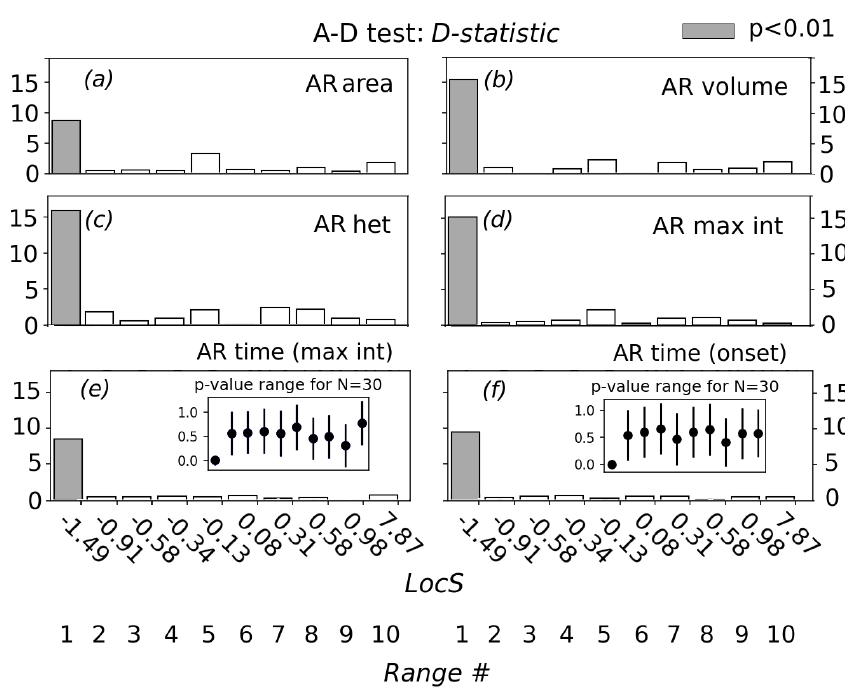
Figure 2. Sensitivity of afternoon rain properties to preceding soil moisture heterogeneity conditions. D-statistic of the Anderson–Darling (A–D) test, i.e., weighted average squared difference between the two selected Empirical Distribution Functions (EDF), for every LocS range ( x -axis) and six rain properties: ( a ) rain area, ( b ) volume, ( c ) spatial heterogeneity, ( d ) maximum intensity, ( e ) time of maximum intensity and ( f ) onset time. The first EDF results from the sample of the specific AR property in the particular LocS range, while the second EDF results from the total sample of that AR property independent of the LocS range. Differences significant at the 99% level ( p -value < 0.01) are shaded in gray. In the case of the two discrete AR time parameters ( e , f ), the calculation of the